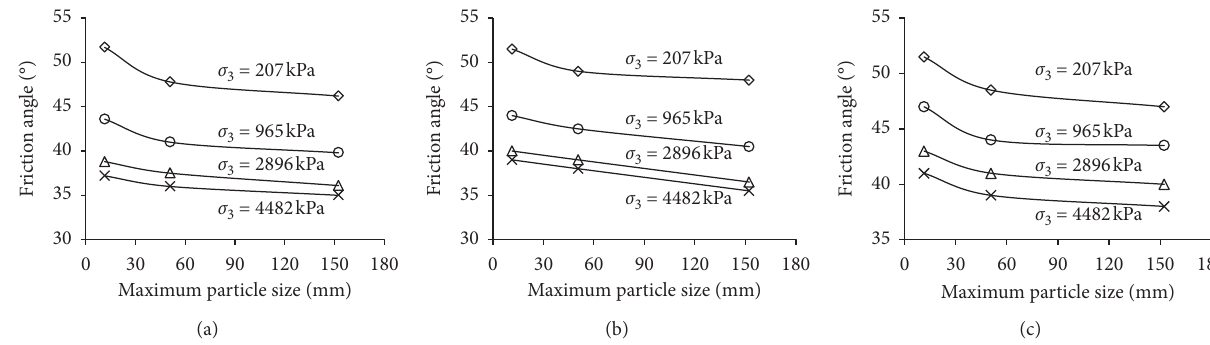
Figure 5: Variations of friction angle with the maximum particle size for (a) Pyramid dam materials, (b) crushed basalt, and (c) Oroville dam materials with different confining pressures (data taken from [86]).